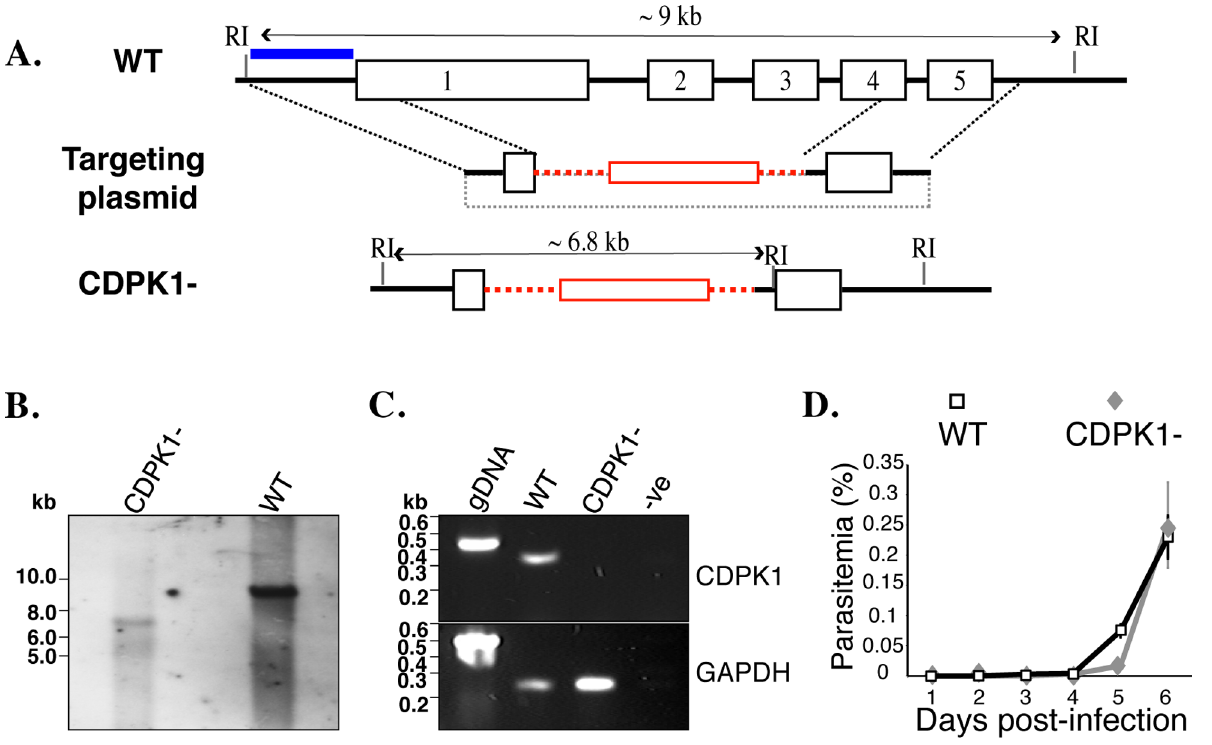
Figure 1. CDPK1- parasites are viable during erythrocytic development. (A) Schematic of PbCDPK1 knockout strategy using homologous recombination. (B) Southern hybridization, using a probe indicated in blue, demonstrates replacement of the PbCDPK1 locus. (C) RT-PCR demonstrates the loss of PbCDPK1 expression in CDPK1- parasites. PbCDPK1 and GAPDH control transcripts were amplified from genomic DNA from WT parasites, from cDNA of WT erythrocytic stages, from cDNA of CDPK1- erythrocytic stages or from water as negative control. (D) CDPK1- erythrocytic stage parasites have a growth rate similar to wildtype in vivo , as determined by daily monitoring of parasitemia of infected mice.